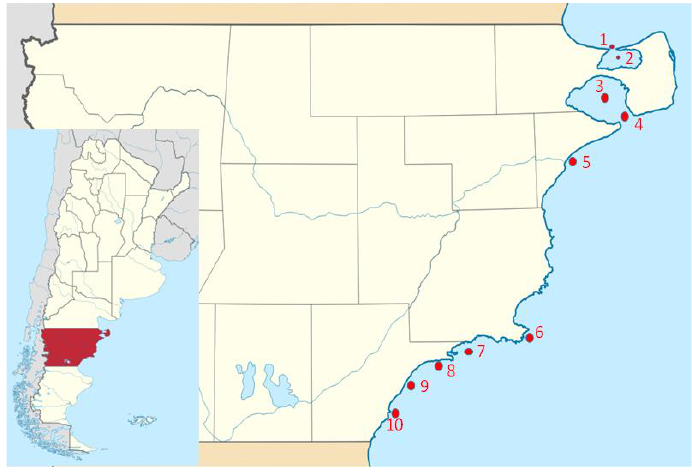
Fig. 2 (a). Tidal height measurements (m) with pressure gauge at Puerto Madryn, January-February-March